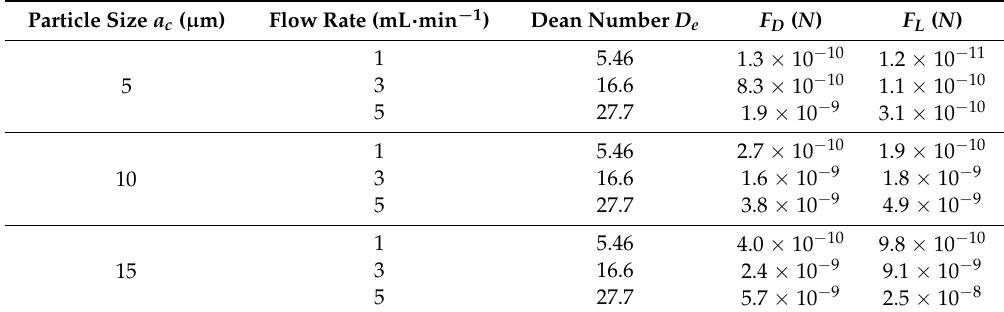
Table 1. Calculated Dean forces and inertial lift forces for different particle sizes and flow rates.